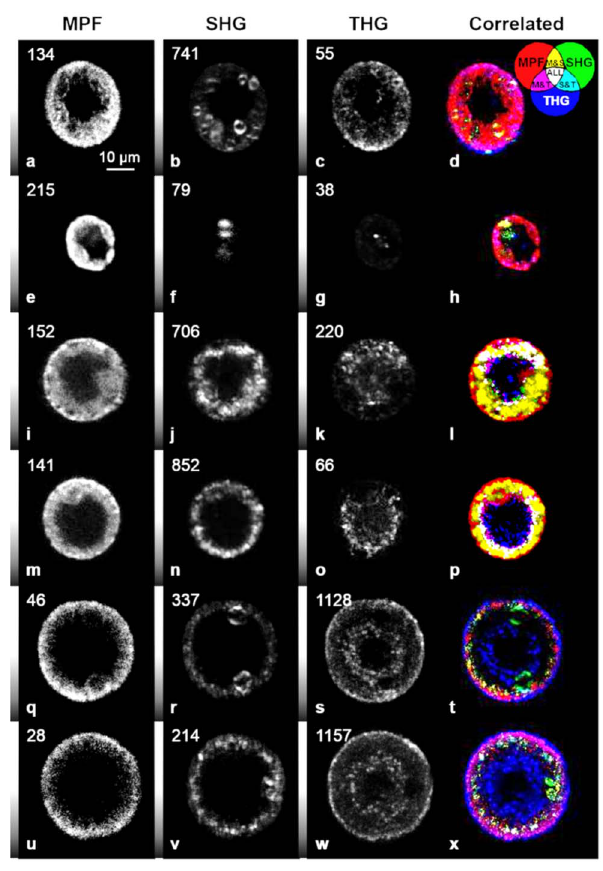
Figure 2. Nonlinear optical microscopy images of Haematococ- cus pluvialis at varying stages of light-stress. (a through h) palmella non-induced cells, (i through p) palmella induced cells and (q through x) aplanospores visualized by (a, e, i, m, q, u) MPF, (b, f, j, n, r, v) SHG, (c, g, k, o, s) THG and (d, h, l, p, t, x) structural image cross- correlation analysis between MPF, SHG and THG [16]. The numbers in the upper left corner indicate the maximum photon counts in a pixel and the grey scale bar on the left side of the image ranges from zero to the maximum signal intensity. In general, a large THG intensity difference is seen between green-colored palmella non-induced cells and red aplanospores where, for example, the red aplanospore (s) is about 20 times more intense than the green-colored palmella non- induced cell (c) due to increased concentration of astaxanthin.